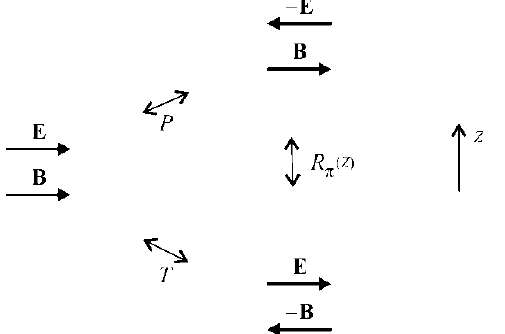
Figure 1. The effect of P and T on Curie’s falsely chiral arrangement of parallel electric and magnetic fields. The antiparallel arrangements generated by P and T separately may be interconverted by a rotation R π ( z ) about an axis z perpendicular to the field directions. Adapted from [15].